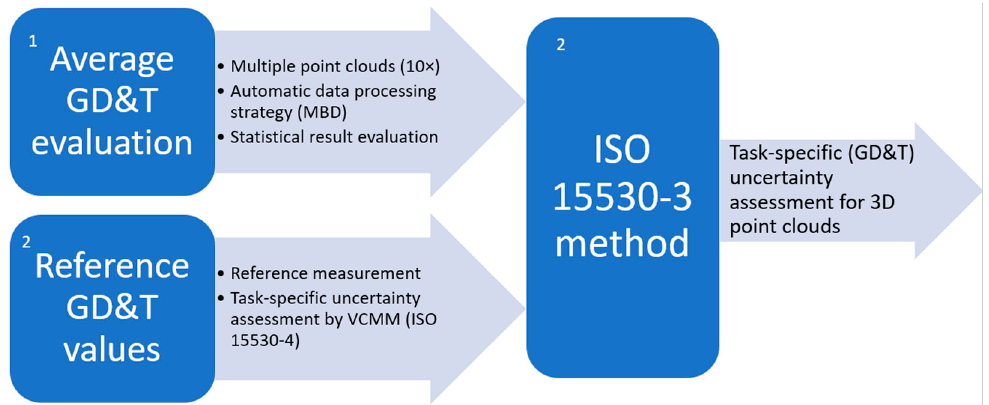
Figure 3. The point cloud measurement uncertainty assessment workflow.